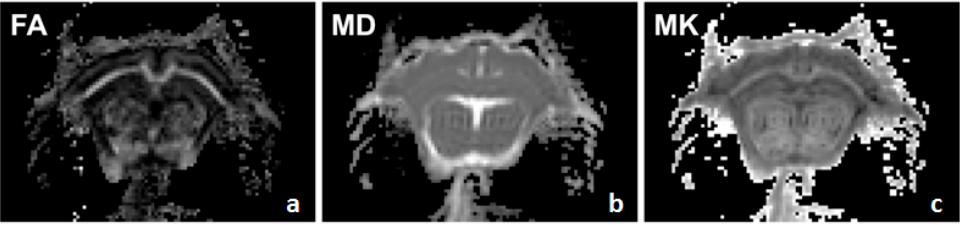
Figure A2. Example of DKI Contrasts. Shown are three identical coronal slices of a normal adult guinea pig brain viewed using the three main DKI parametric images including fractional anisotropy image (a), mean diffusivity image (b), and mean kurtosis image (c). Brighter areas of the image indicate a higher value/intensity in the indicated DKI parameter. In this medial slice, the cortex, hippocampus, and thalamus can be seen looking from top to bottom in each image. Image created in FSLview thresholded at 0 (lowest) and 1 (highest).